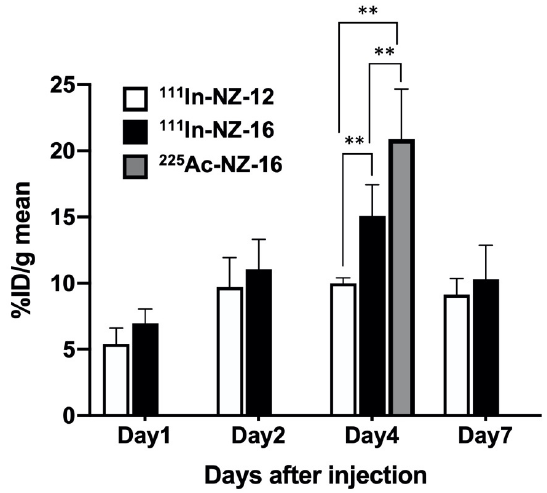
Figure 2. Tumor uptake of 111 In-labeled NZ-12 (N = 4), and 111 In- labeled NZ-16 (N = 5) and 225 Ac-labeled NZ-16 (N = 5). Data indicate the mean and standard deviation (N = 4–5). ** p < 0.01.